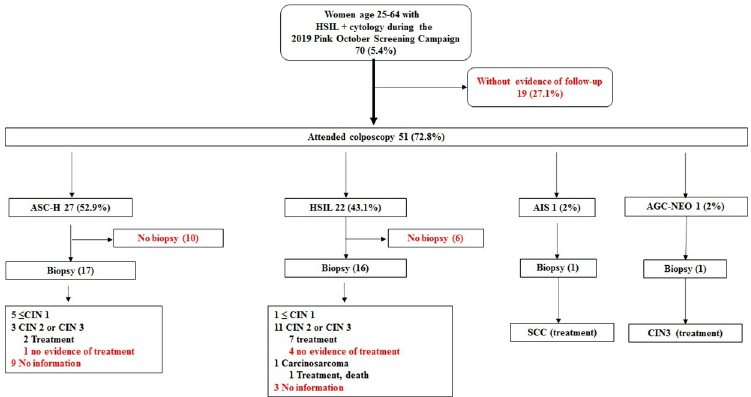
Fig 3. Clinical follow-up and results for women with high-grade cytology result in Manaus, Brazil. ASC-H: Atypical squamous cells, cannot rule-out high-grade squamous intraepithelial lesion; AGC: Atypical glandular cells; HSIL: High-grade squamous intraepithelial lesion; SCC: Squamous cell carcinoma. CIN1 � : Grade I Cervical Intraepithelial neoplasia, chronic cervicitis with squamous metaplasia and Ectocervix without significant histological changes. CIN2 � (Grade II Cervical Intraepithelial Neoplasia, Grade III Cervical Intraepithelial Neoplasia). Months between cytology and colposcopy/biopsy: mean = 4.17 months, median = 2 months.